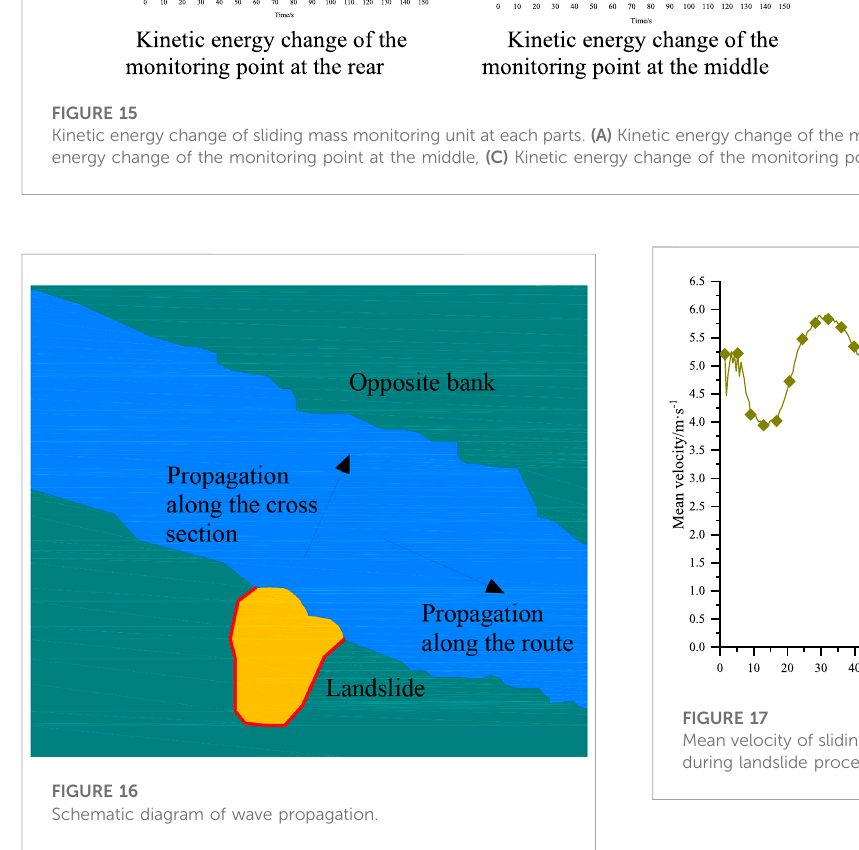
FIGURE 17 Mean velocity of sliding mass units entering water with time during landslide